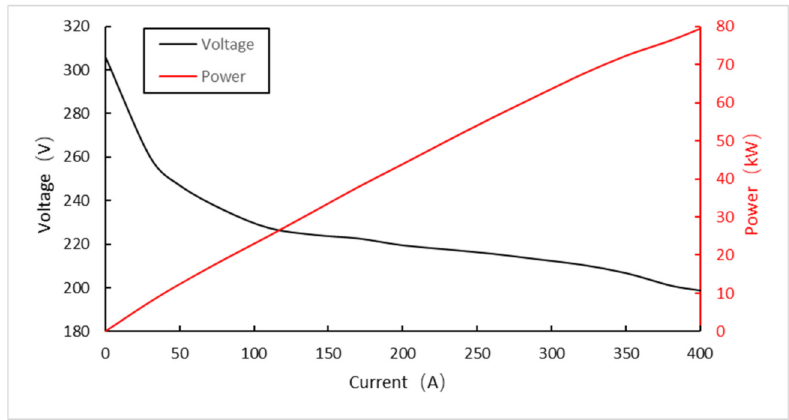
Figure 3. Current, voltage and power curves of the fuel cell